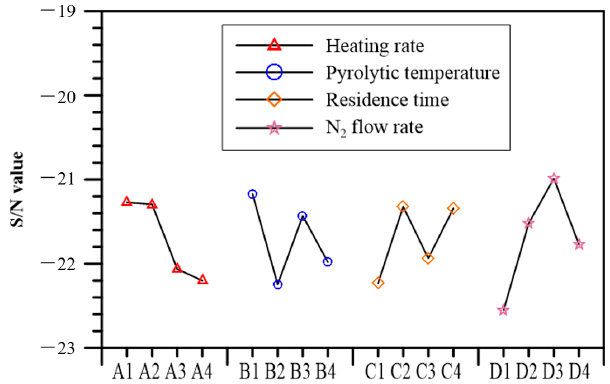
Figure 5. S / N response for sludge pyrolytic oil.